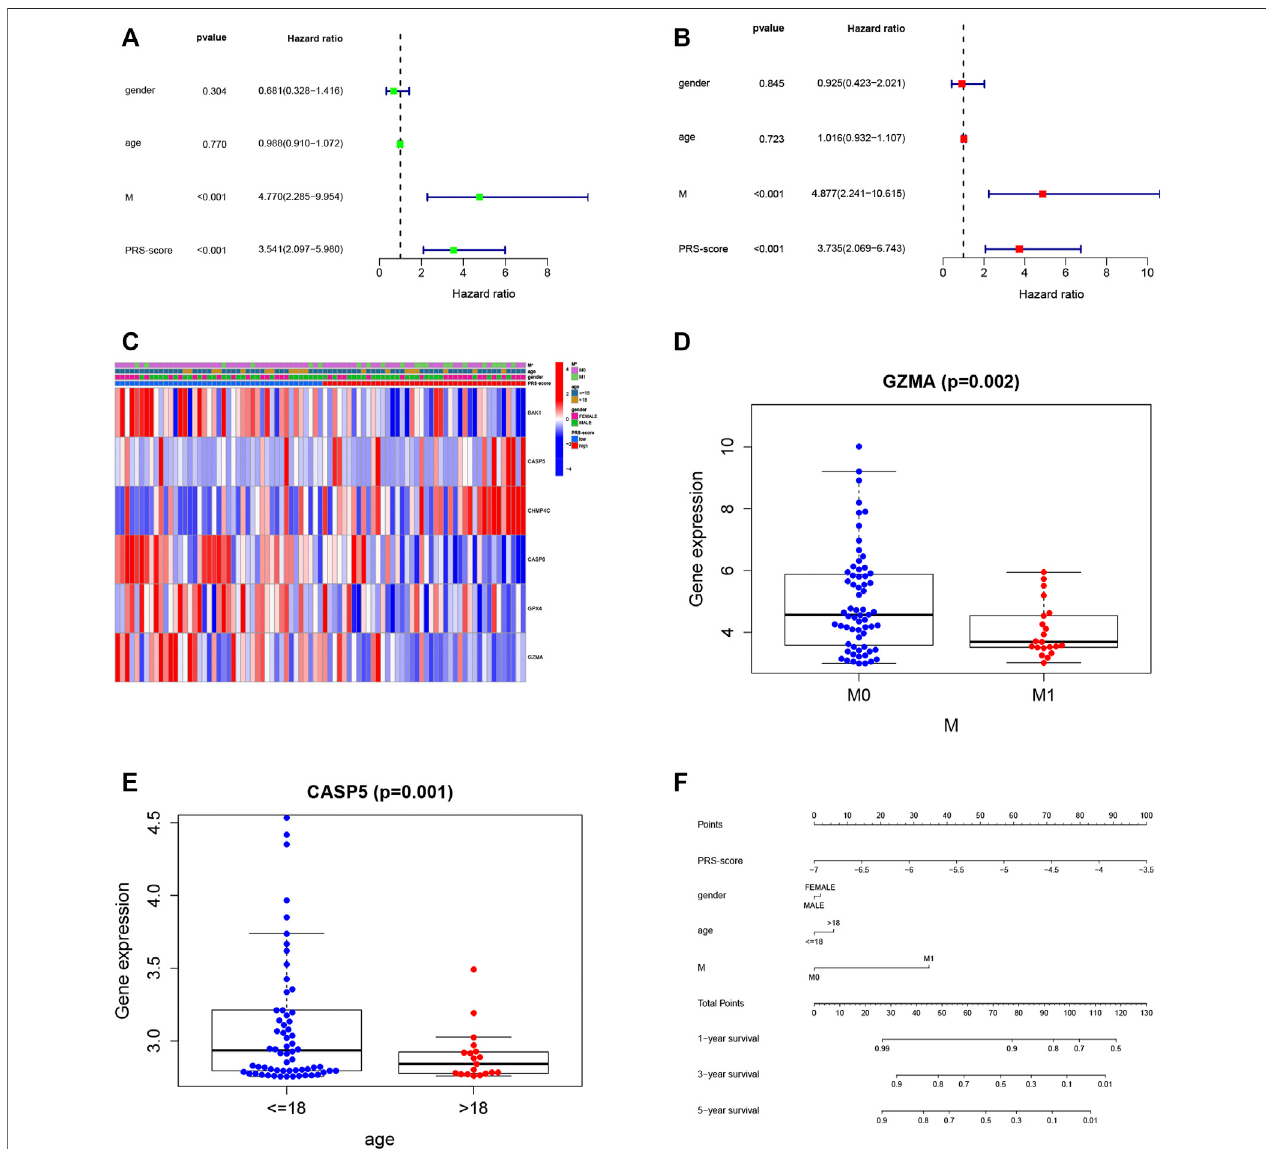
FIGURE6| Independentprognosisanalysisandclinicalutility. (A,B) Coxregressionanalysisofpyroptosis-related genes (A) UnivariateCoxregressionanalysis (B) Multivariate Cox regression analysis (C) Heatmap (blue: low expression level; red: high expression level) of the correlation between clinical features and the risk groups (* p < 0.05) (D) Relationship betweenGZMAand metastasis. (E) Relationship betweenCASP5and agecategory. (F) Aprognosticnomogram basedonthePRG-related model for prediction of 1-, 3-, and 5-year survival